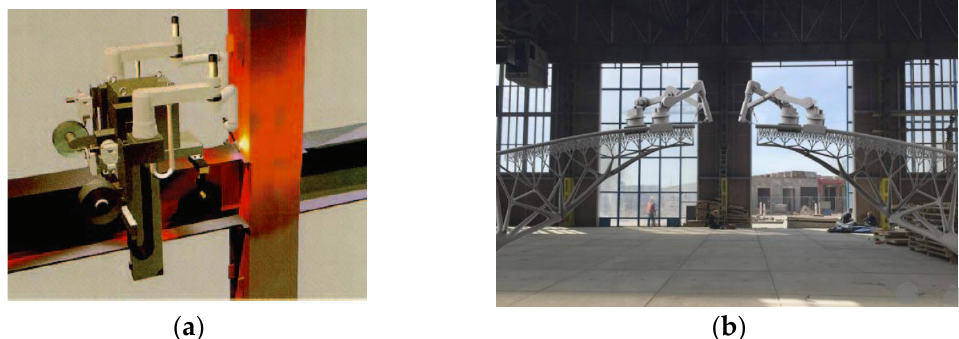
Figure 6. Welding robot ( a ) Mobile Welding robot; ( b ) Welding robots attaching on structure [125,126,128].